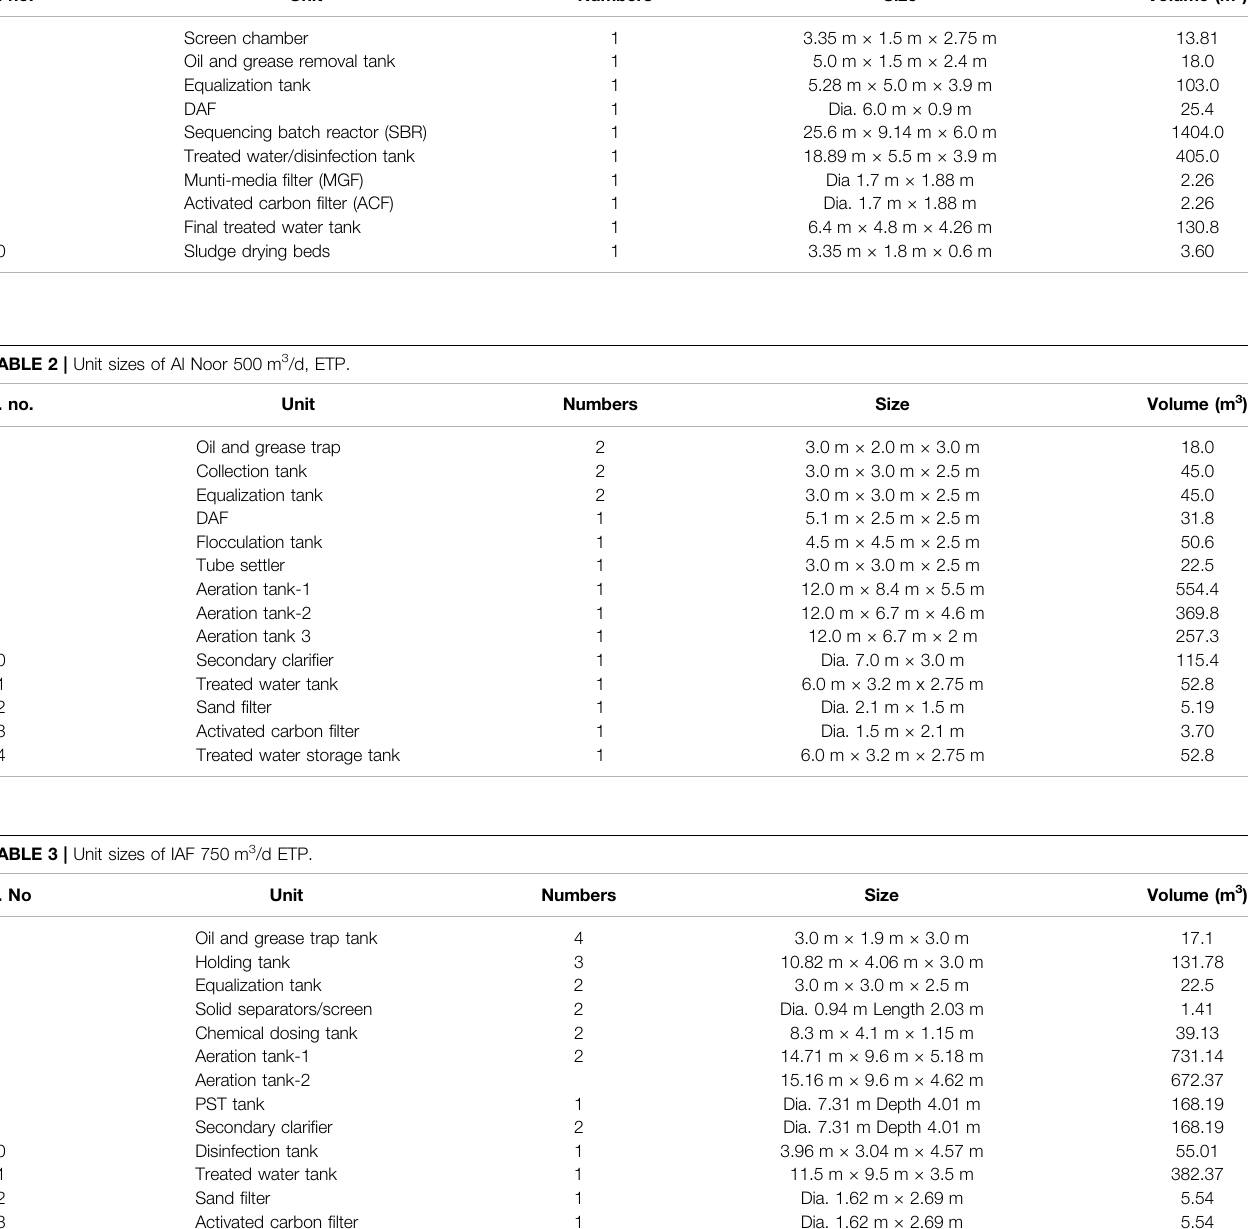
TABLE 1 | Unit sizes of Meem Agro 500 m 3 /d, ETP. S. no.